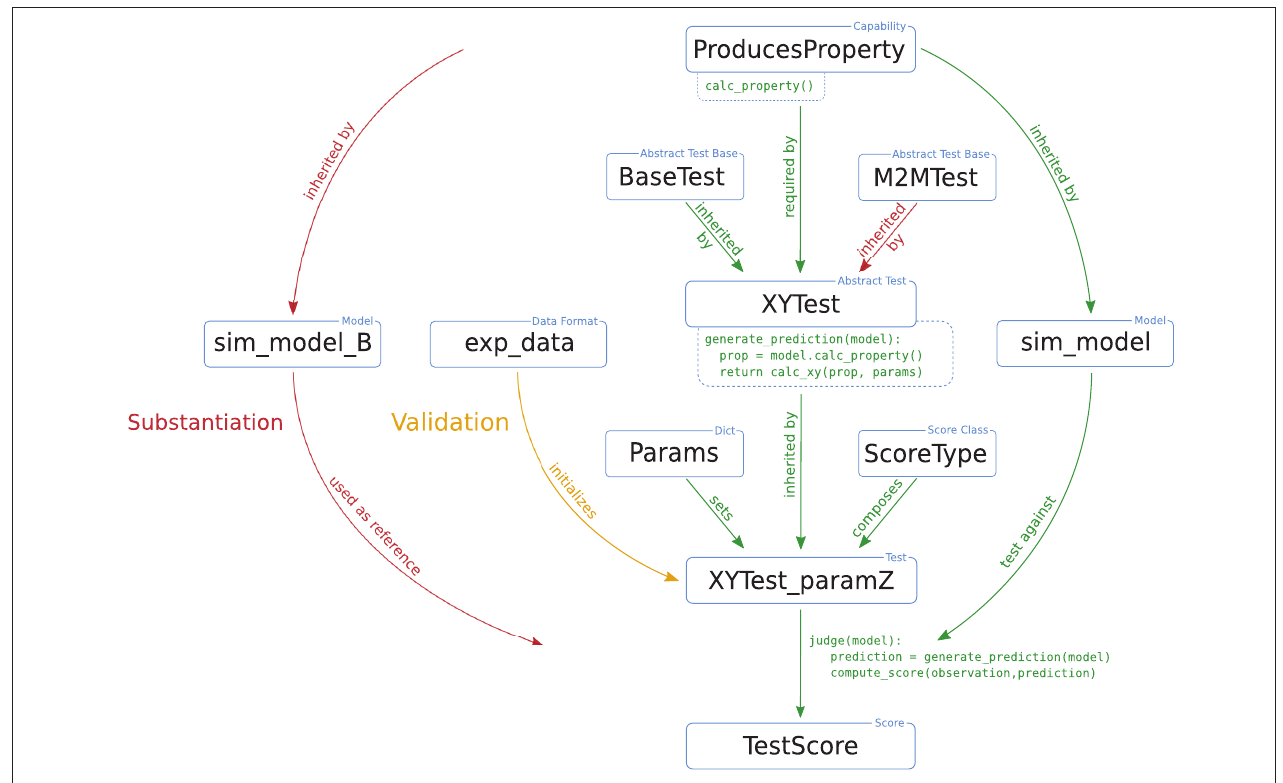
FIGURE 3 | Illustration of a typical test design within NetworkUnit . The blue boxes indicate the components of the implementation of the validation test, i.e., classes, class instances, data sets, and parameters. The relation between the boxes are indicated by annotated arrows. The basic functionality is shown by green arrows. The difference in the test design for comparing against experimental data (validation) and another simulation (substantiation) is indicated by yellow and red arrows, respectively. The relevant functionality of some components for the computation of test score is indicated by pseudo-code. The capability class ProducesProperty contains the function calc_property() . The test XYTest has a function generate_prediction() which makes use of this capability, inherited by the model class, to generate a model prediction. The initialized test instance XYTest_paramZ makes use of its judge() function to evaluate this model prediction and compute the score TestScore . The XYTest can inherit from multiple abstract test classes ( BaseTest ), which is for example used with the M2MTest to add the functionality of evaluating multiple model classes. To make the test executable it has to be linked to a ScoreType and all free parameters need to be set (by a Params dict) to ensure a reproducible